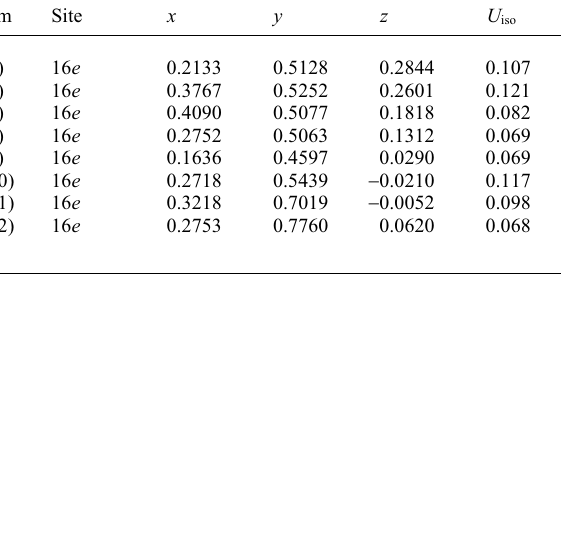
Table 2. Atomic coordinates and displacement parameters (in Å 2 ) .